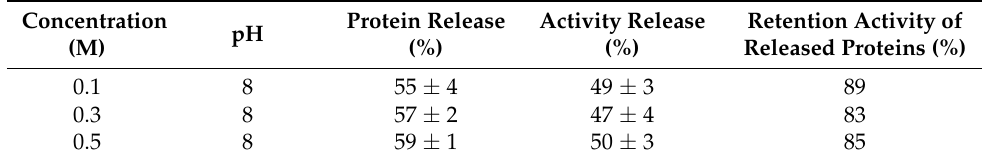
Table 6. Cutinase release and residual activity in sodium phosphate buffer pH 8 at different concen- trations after 4 h; the retained activity is calculated with respect to the protein released.